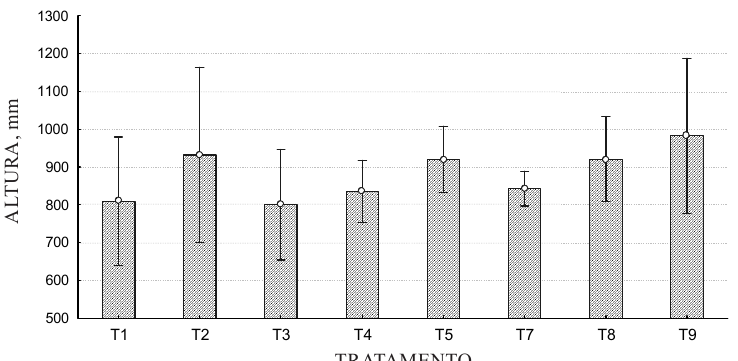
Figura 2. Média (n = 4) da altura do eucalipto aos 12 meses de idade em cada tratamento. A variação é o Intervalo de Confiança calculado com 95 % de